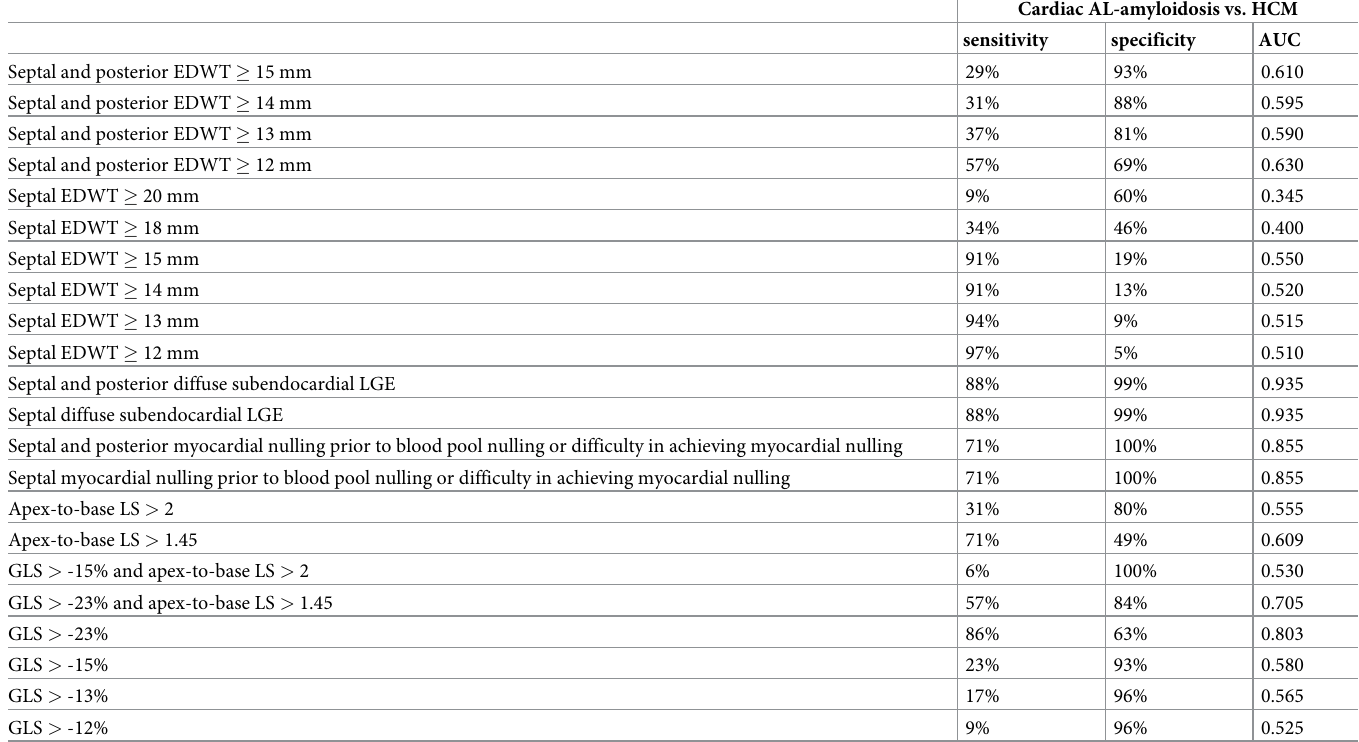
Cardiac AL-amyloidosis vs.